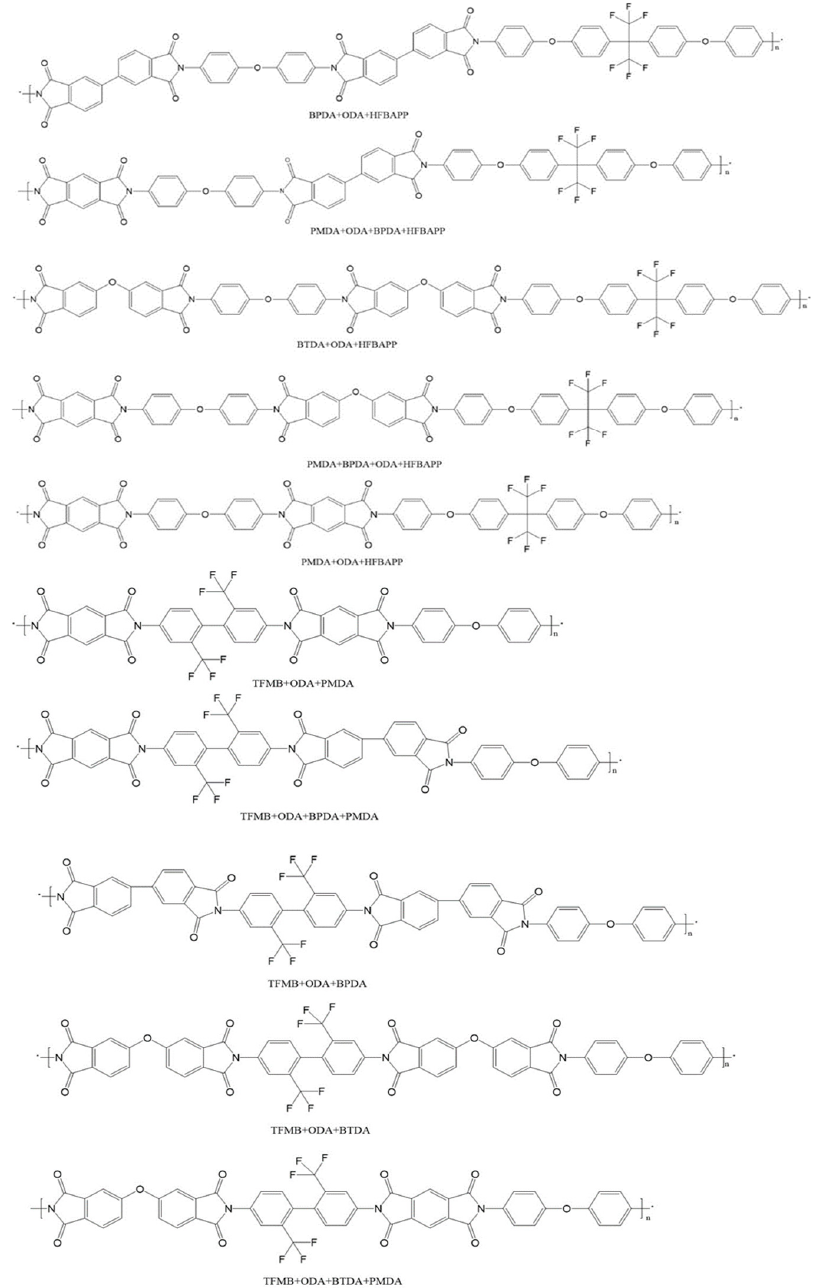
Figure 2. Molecular structure diagram of PIs of Group HFOB, HFOP, TFOB and TFOP.